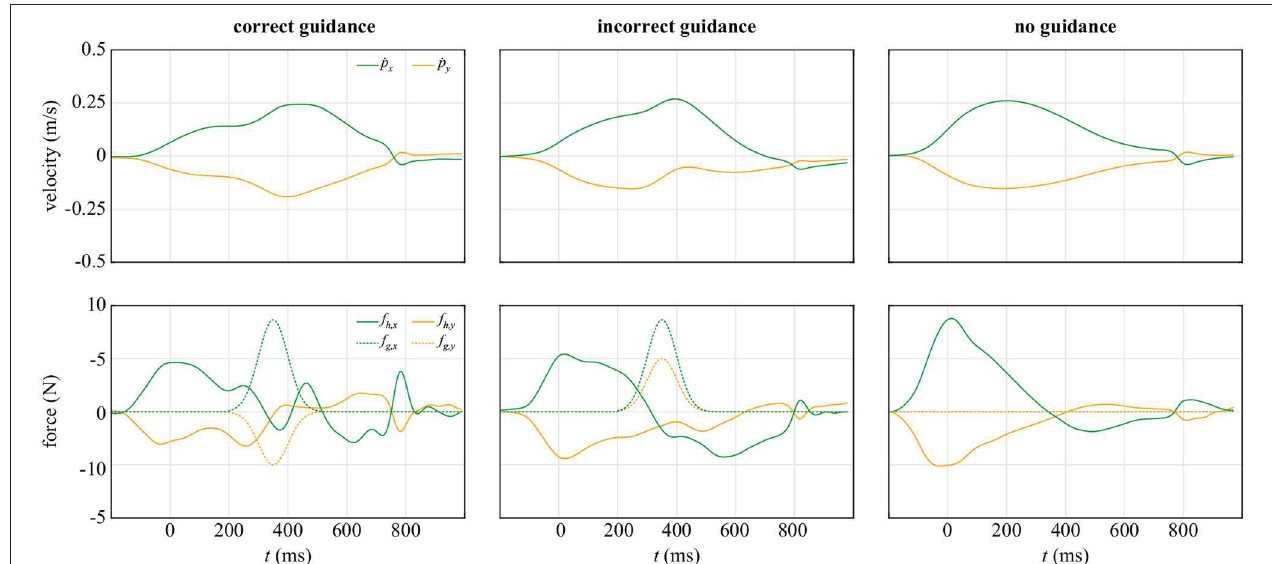
FIGURE 2 | Exemplary velocities of the manipulandum and forces in a single trial. All examples are when the participants reached to the left target, and the incorrect guidance was directed toward the right target. The cursor fully left the starting circle at t = 0 which represented a start of a trial. The increase of f h magnitude at around 800 ms is due to the contact with the virtual wall of the target